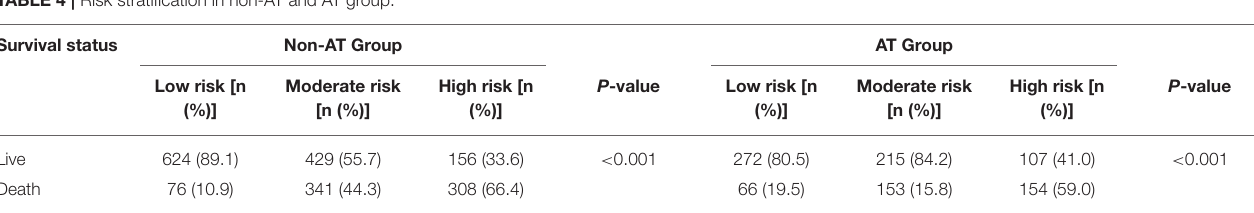
TABLE 4 | Risk stratification in non-AT and AT